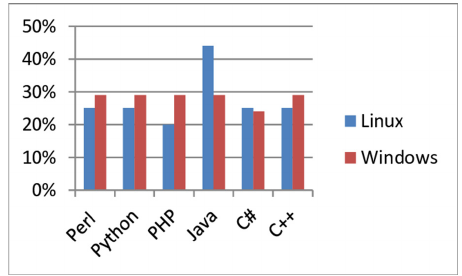
Fig. 6. Programming language performance